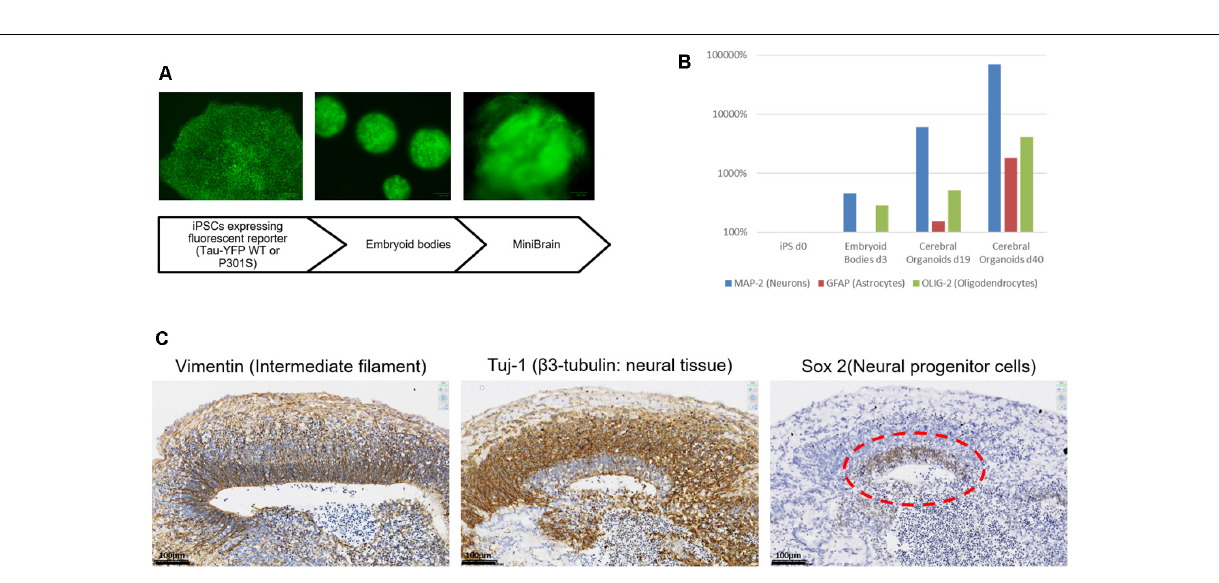
FIGURE 3 | MiniBrain generation with modified iPSCs for pathological modeling. (A) Diagram showing the major steps of the MiniBrain protocol from iPSCs to cerebral organoids. (B) Real-time PCR analysis shows the expression of different neural markers at different time points in the cerebral organoid formation protocol, MAP-2 for neuron evaluation, GFAP for astrocyte evaluation and Olig-2 for oligodendrocyte evaluation. (C) Tissue sections of a 30-day cerebral organoid showing the development of neural rosettes with a radial organization, as shown with vimentin staining. Sox-2 staining reveals a neural stem cell niche, from which a neuronal network is developing as can be seen with the Tuj1